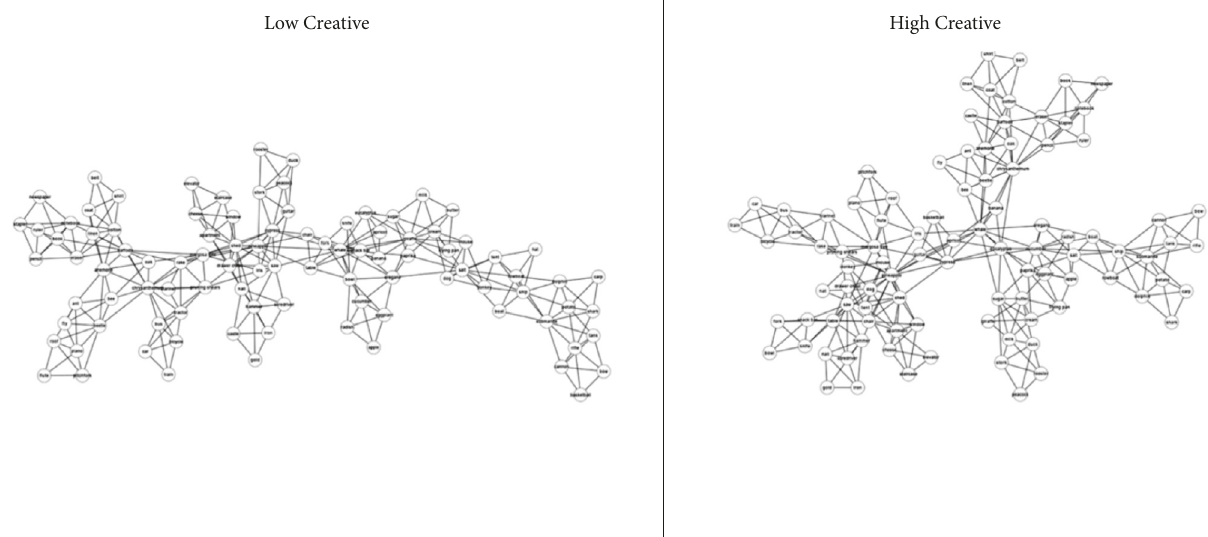
Figure 5: 2-D representation of a 96 node (cue words) semantic network of individuals with high and low levels of creative ability. Edges represent a binary, symmetric relation between nodes. Adapted from Kenett et al.